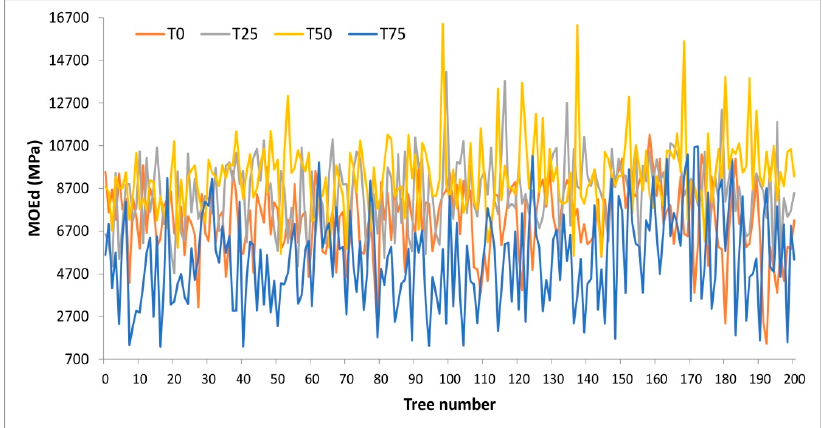
Figure 4. MOEd values obtained for all the sampled trees. Different colors refer to the four intensities of thinning.